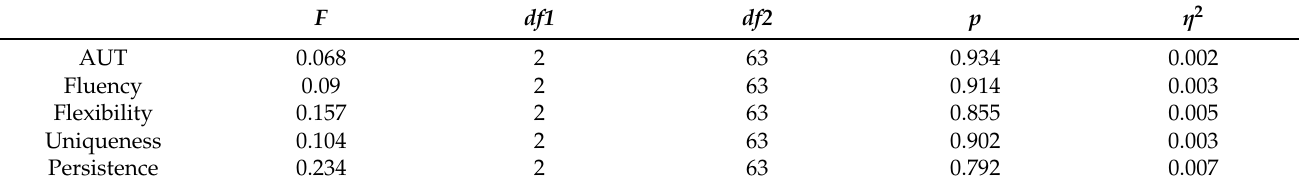
Table A2. Results of variance analysis of the change of AUT.